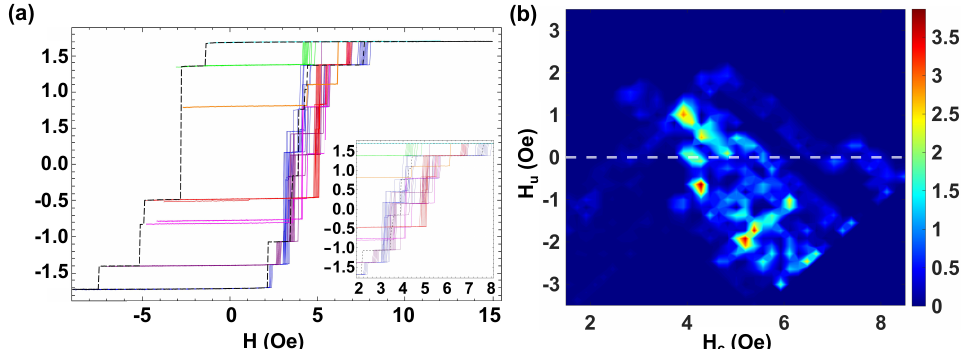
Figure 7. ( a ) MHL (black line) and FORC curves (color lines) for seven Fe 77.5 B 15 Si 7.5 microwires with different coercive fields H c ∈ ( 2,8 ) and κ ∈ ( 0.25,0.4 ) placed side by side. ( b ) Corresponding FORC